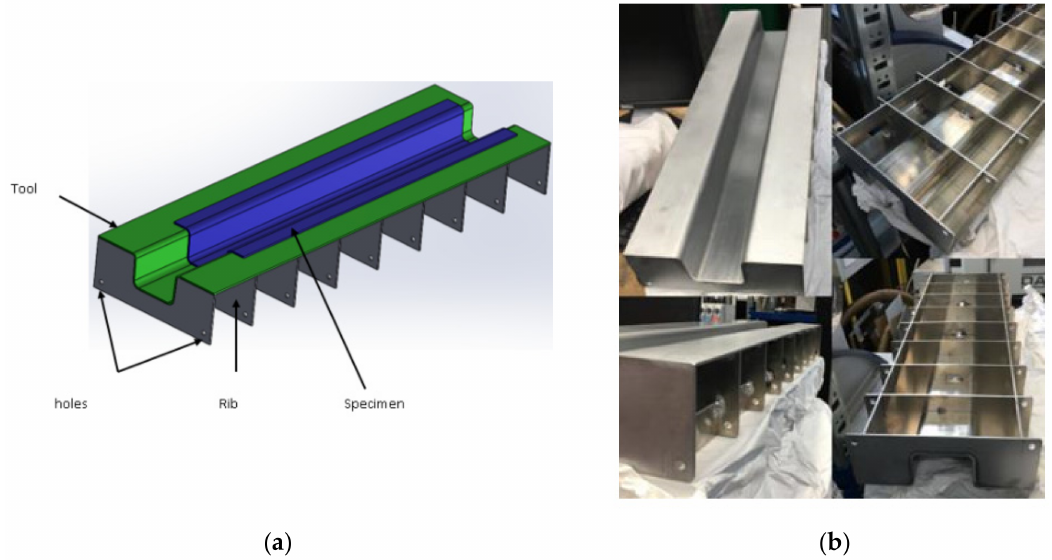
Figure 1. ( a ) Overview of fabrication tool and specimen ( b ) tool